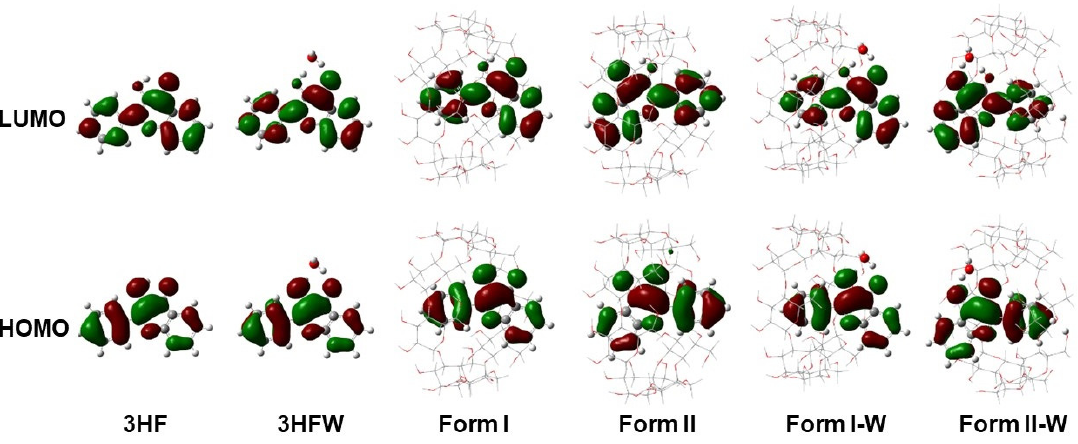
Figure 5. Frontier MOs of all studied compounds.